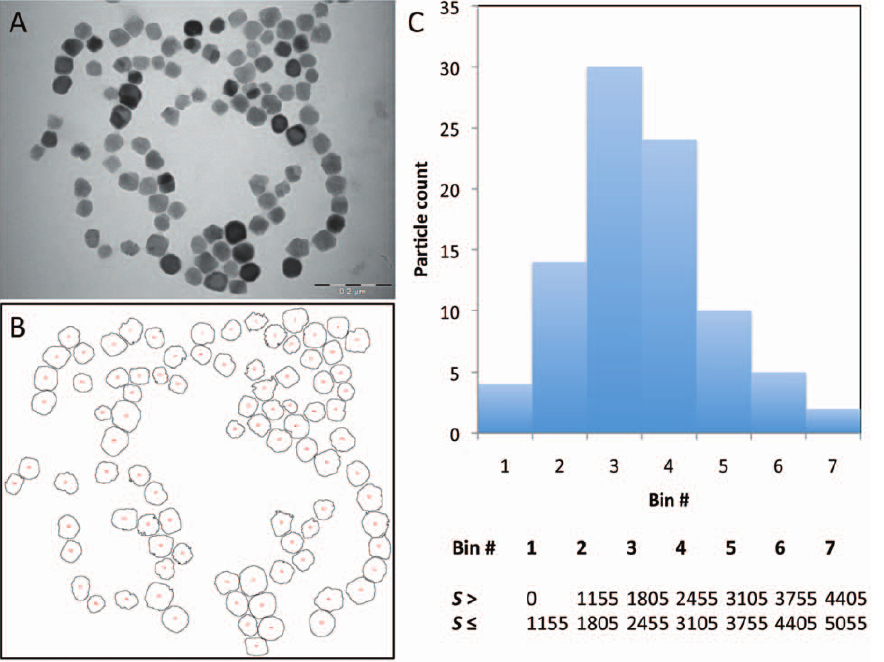
Figure 4. An estimate of the volume of a single particle from TEM images. Scale bar is 0.2 m m. ( a ) Unprocessed TEM image of the functionalized magnetosomes. ( b ) Automatic particle counting and sizing analyzed by ImageJ. ( c ) Particles size distribution computed with 7 bins (boundaries are given in the table). The surface S is expressed in pixel 2 .